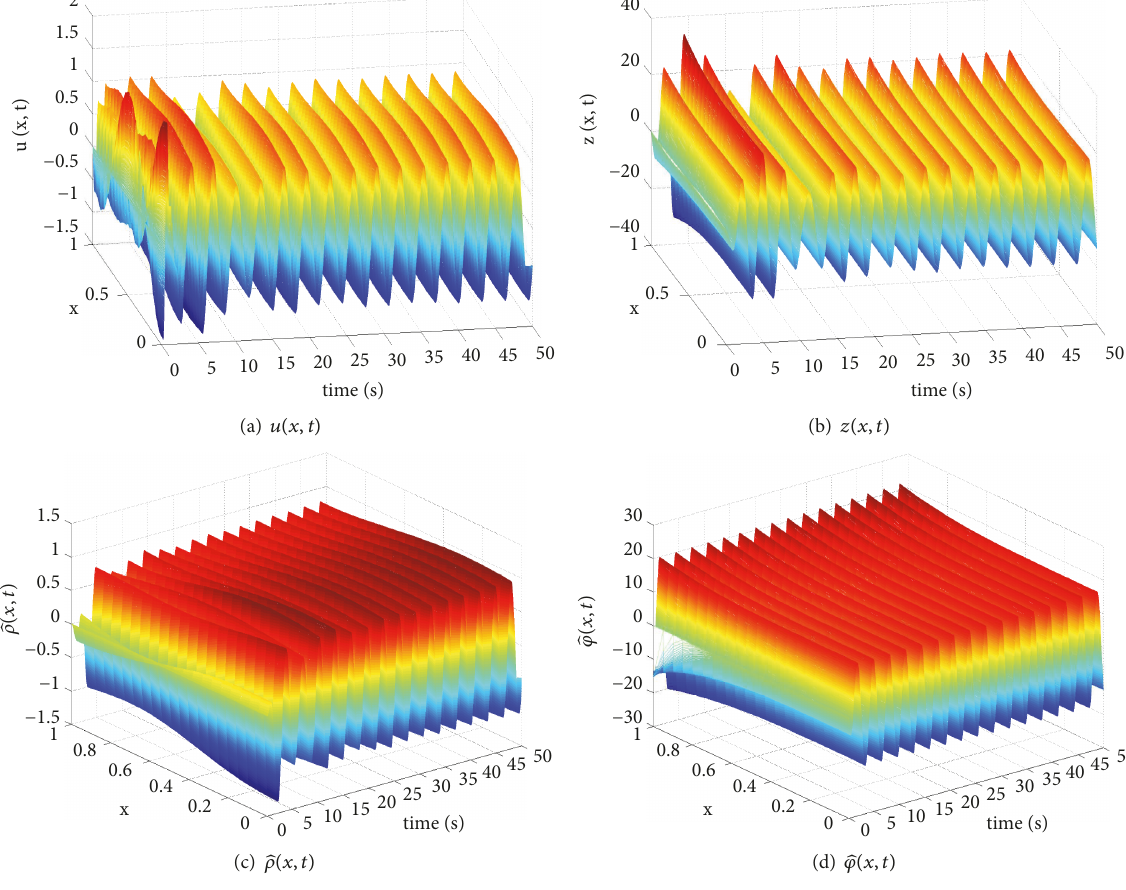
Figure 1: The solution of closed-loop system.